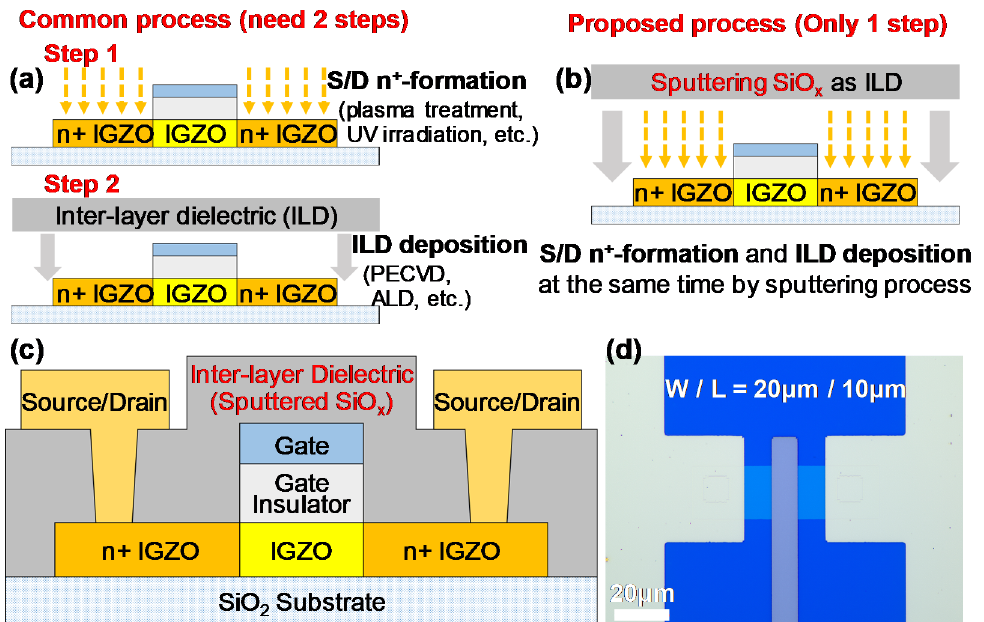
Figure 1. ( a ) Common two-step process and ( b ) proposed one-step process for IGZO n + -region formation and ILD deposition. ( c ) Cross-sectional diagram and ( d ) optical microscope image of the fabricated SA coplanar IGZO TFT.